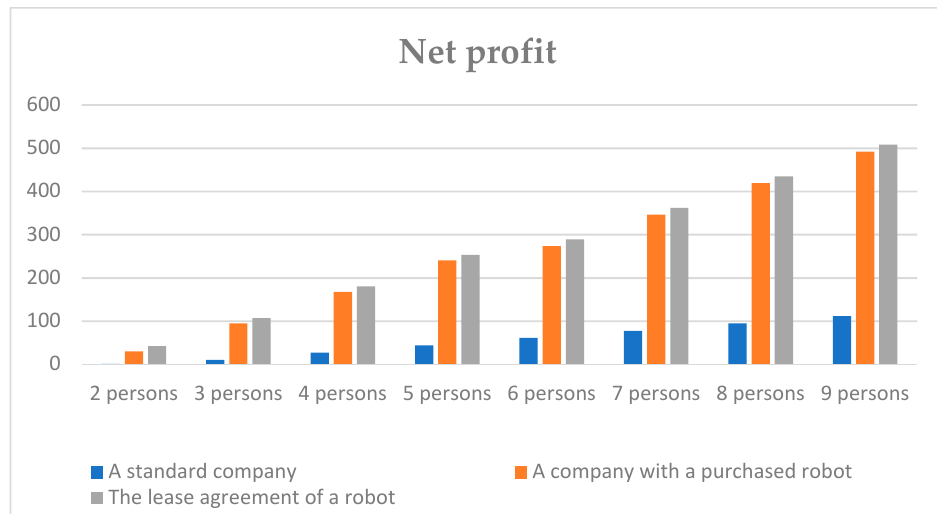
Figure 3. Net profit of an enterprise in three varieties for businesses employing between 2 and 9 people (PLN thousand). Taxes do not include the tax on robotification.